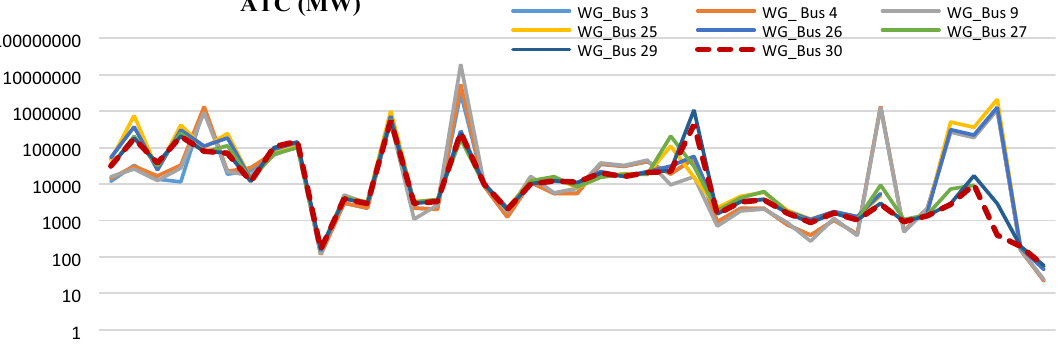
Fig. 4 ATC Comparison in limiting line between bus 6–28 due to optimally placed WG in Zone